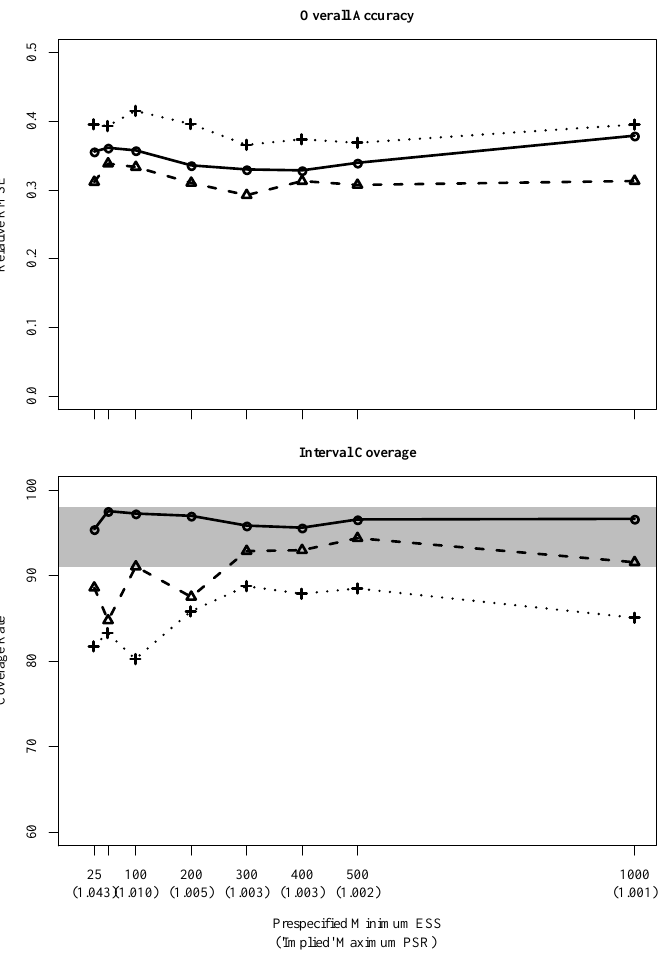
Figure 3. Relative bias, relative root mean squared error (RMSE), and coverage rate for the different prespecified minimum effective sample